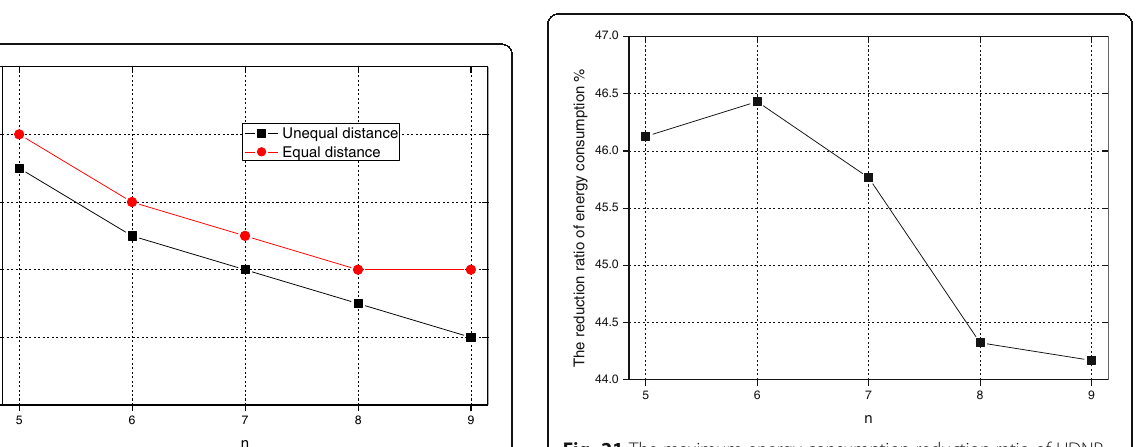
Fig. 21 The maximum energy consumption reduction ratio of UDNP